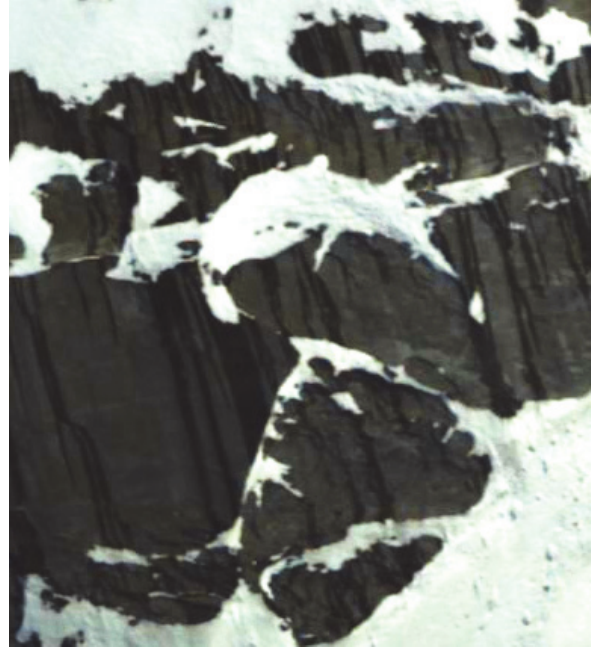
Figure 8. Detail of Figure 7 with a GSD of circa 12 cm on a steep